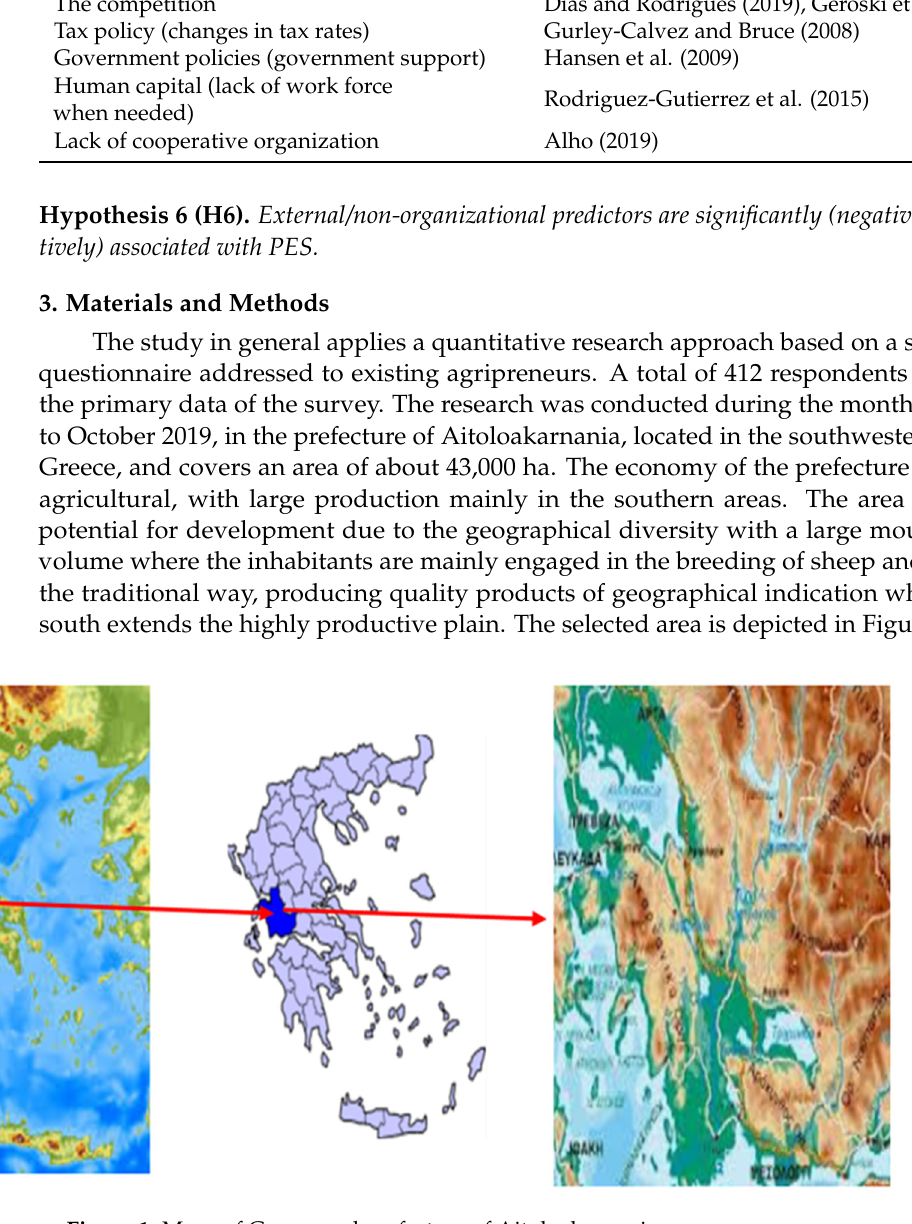
Figure 1. Maps of Greece and prefecture of Aitoloakarnania.